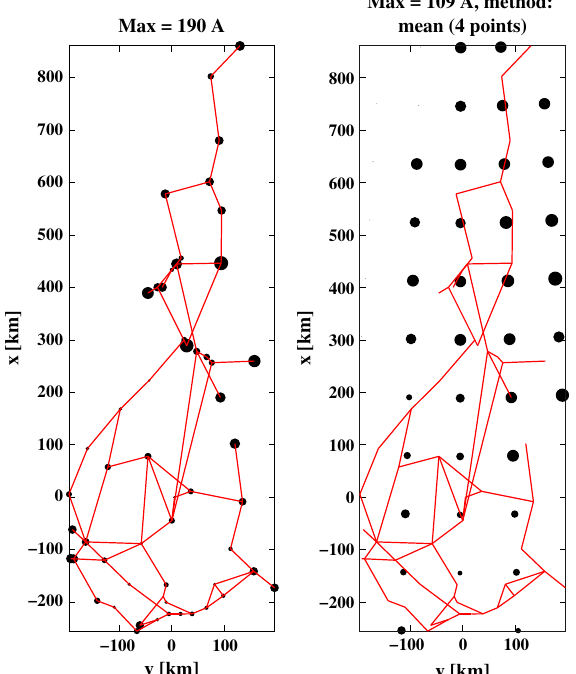
Fig. 4. Left: maximum of the modelled GIC at the substations of the Finnish high-voltage power grid in 1996–2008. Right: regionally averaged presentation of the maximum GIC. The scale of the dots is different in the